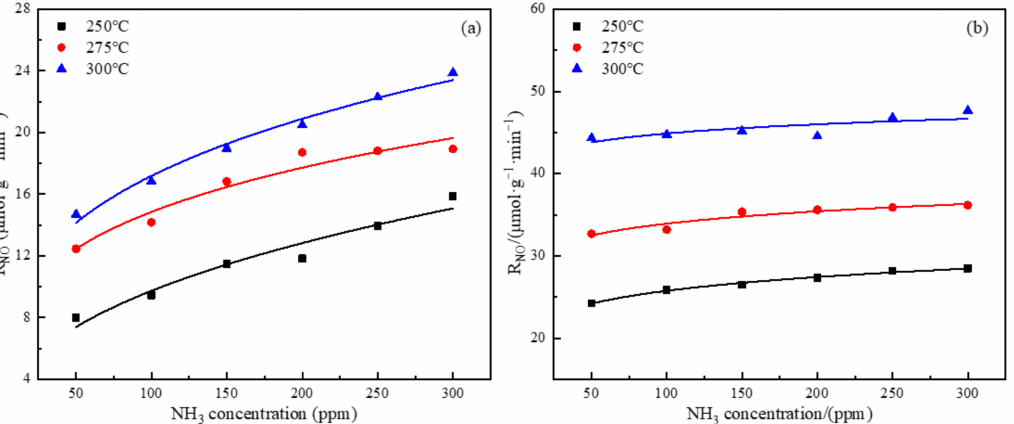
Figure 4. Effect of NH 3 concentration on the rate of NO conversion ( a ) SOC, W/F = 0.9 kg · s · L − 1 ,